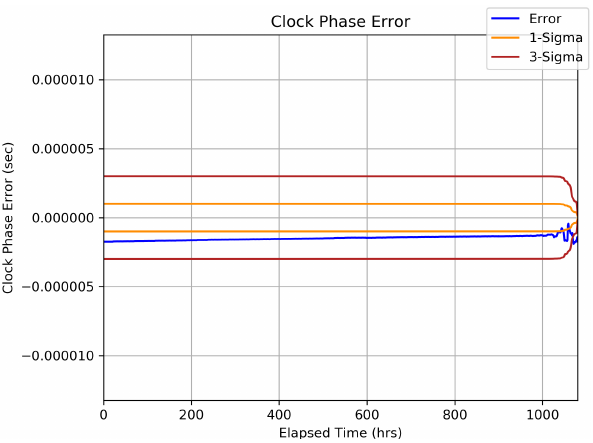
Figure 14. Clock phase error and uncertainty for fused filter in Large Radiometric Bias